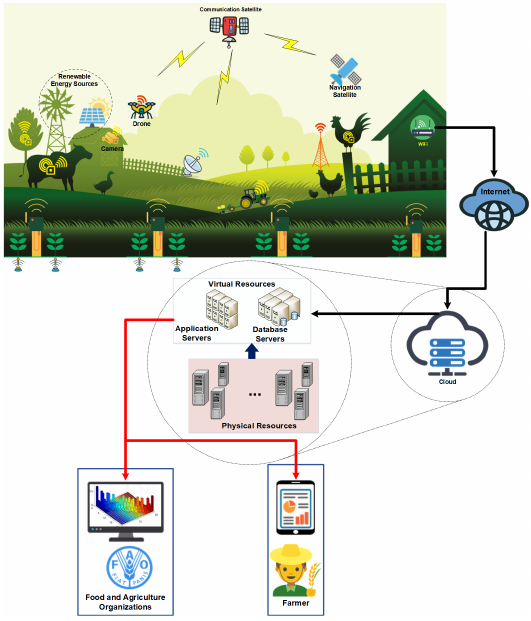
Figure 1. Digital Agriculture